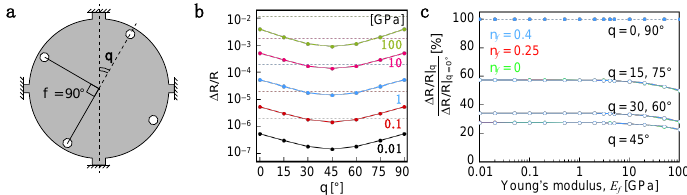
110100 0.1 0.01 Figure A1. Dependence of the relative resistance change ( ∆ R / R | total ) on the position of the interfacial attachments from the four sensing beams of the MSS calculated by FEA. ( a ) Configuration of pillars as a model of interfacial attachment. The radius of pillars ( r pillar ) and the number of pillars ( N ) are fixed at 1 µm and 4, respectively, with the angle φ = 90 ◦ . ( b ) Dependence of the total resistance change R / R | total on Young’s modulus as a function of the angle of pillars from y axis. The Young’s moduli ( E f ) are varied from 0.01 GPa to 100 GPa. Poisson’s ratio of a coating film ( f ) is fixed at 0.4. Dotted lines are R / R | total of the fully attached models. ( c ) Dependence of the relative resistance change R / R | total on Young’s modulus and Poisson’s ratio. Supplementary Materials: The following are available online at www.mdpi.com/xxx/s1, Supplementary text: Detailed experimental procedure, Figure S1: Distribution of displacements and relative resistance change on the interfacial structure, Figures S2, S3, and S5: the distributions of relative resistance changes, Figure S4: Comparison between the distance-fixed model and fully attached model with different radius of a receptor layer, Table S1; The list of detailed parameters of the interfacial structures.